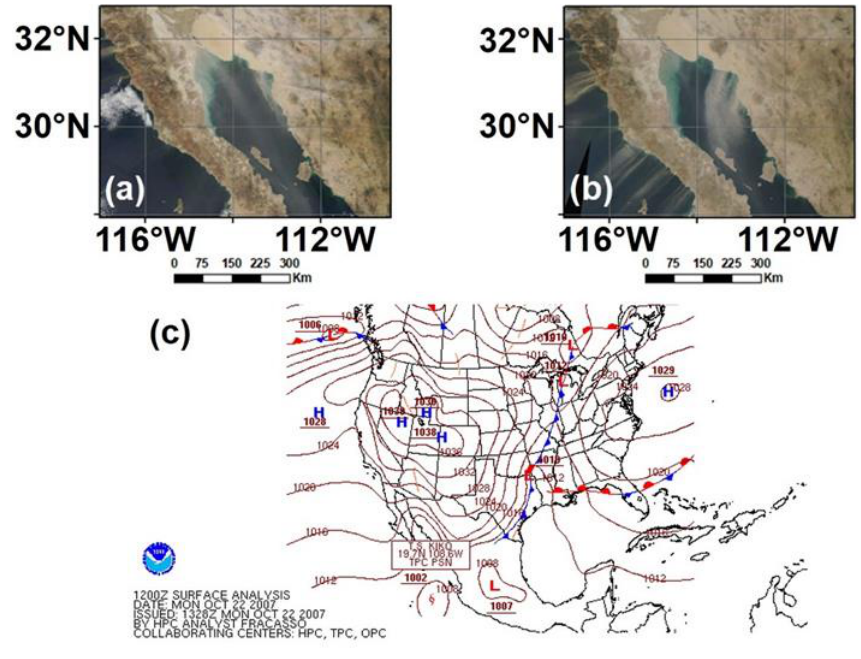
Figure 2. Moderate Resolution Spectroradiometer image (MODIS) from NASA’s Terra satellite. ( a ) Dust storms on 21 October 2007, ( b ) dust storms on 22 October 2007 in which is observed transported dust above the Gulf of California and ( c ) Surface level chart at 12:00 UTC on 22 October 2007 from the NOAA / National Weather Service.